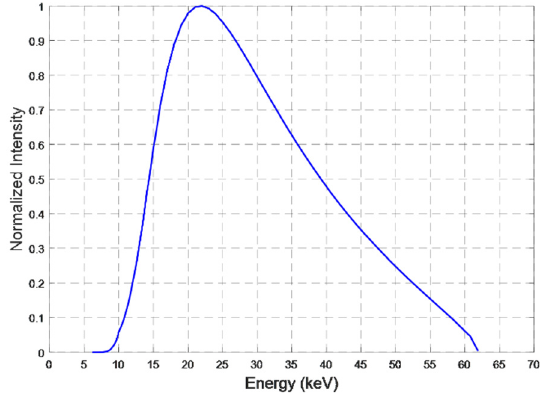
Figure 5. Spectrum of sheet ‐ beam X ‐ ray source.